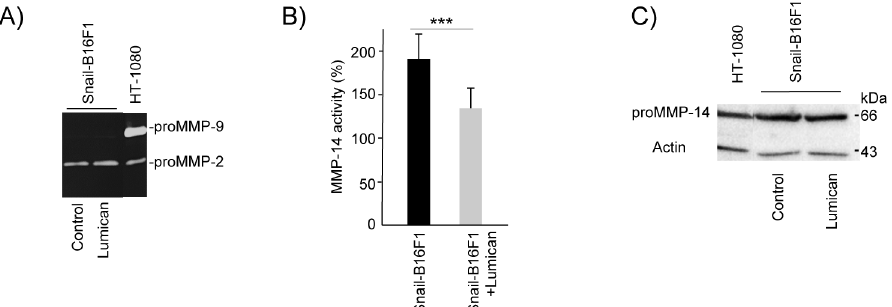
Fig 4. Effect of lumican on MMP-2,-9 and MMP-14 expression and activity in Snail-B16F1 cells. (A) Effect of lumican on MMP-2 and -9 activities in Snail overexpressing B16F1 cells (clone Snail19-B16F1). (B) Activity of MMP-14 in Snail-B16F1 cells (clone Snail19-B16F1) incubated 24h in the absence or in the presence of 100 nM lumican as described in Materials and Methods using fluorometric SensoLyte ™ 520 MMP-14 Assay Kit. Data given as mean ± SD, n = 6. Asterisk ( * ) indicates statistically significant differences between control and 100 nM lumican incubated Snail overexpressing B16F1 cells, ( *** p < 0.001). Significance of differences estimated with block two-way ANOVA, using the cell line and the presence of lumican as grouping variables, and the post hoc Scheffe ’ s multiple comparisons test and contrast analysis. (C) Western blot analysis of MMP-14 expression in Snail overexpressing B16F1 cells (clone Snail19-B16F1) in the absence or in the presence of 100 nM